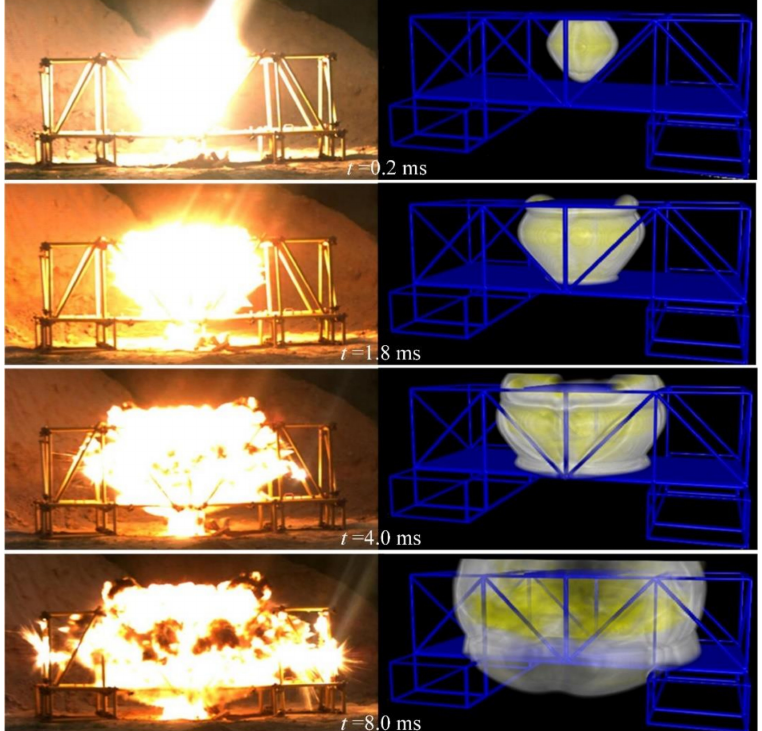
Figure 15. Comparison between the scenario with a certain explosion height and the experimental data.